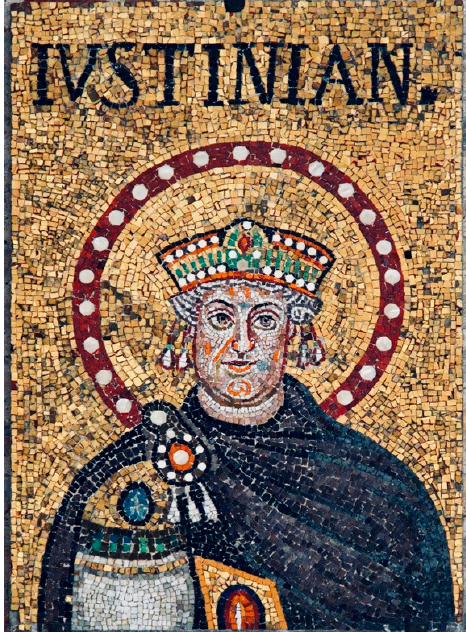
Figure 2. Mosaic panel representing an emperor, Basilica of Sant’Apollinare Nuovo, Ravenna (photo: Ввласенко , Wikimedia Commons, CC BY-SA 3.0, cropped).